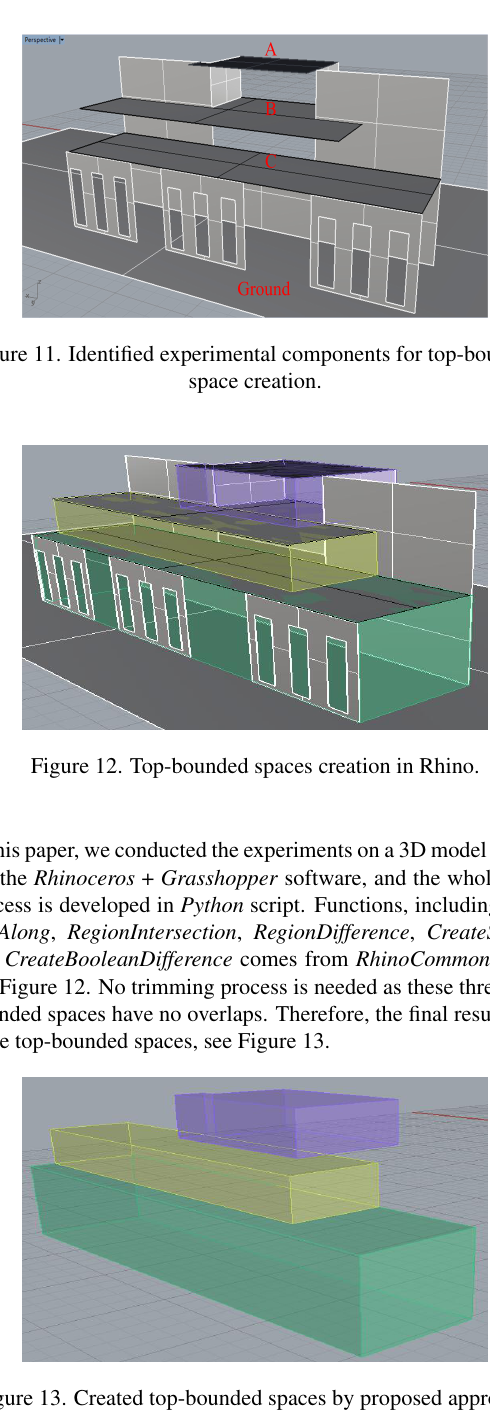
Figure 13. Created top-bounded spaces by proposed approach.